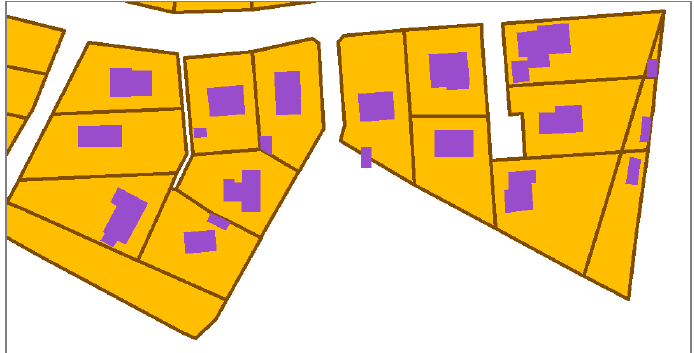
Figure 15. Disconnected sets of land use parcels that can be partitioned and treated